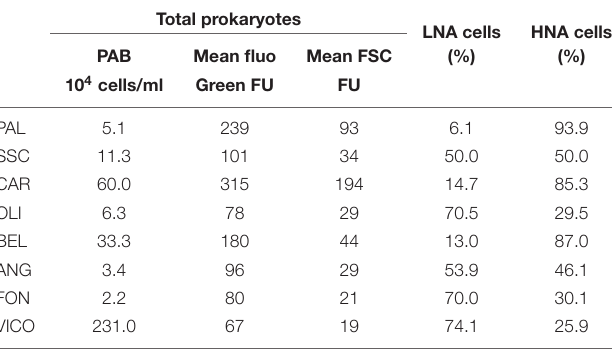
TABLE 2 | Main cytometric characteristics of thermal waters, groundwaters and lake